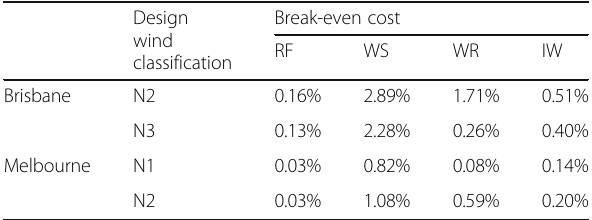
Table 9 Break-even adaptation costs (normalized by the building value) for different climate adaptation measures to be cost-effective (with construction